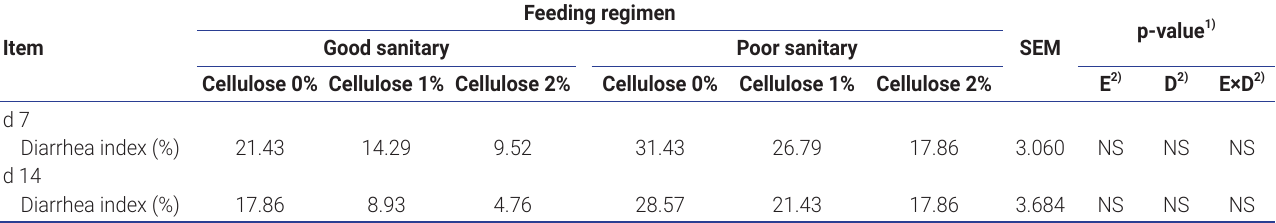
Table 4. Effects of environmental conditions and cellulose levels on diarrhoea index in weaned pigs